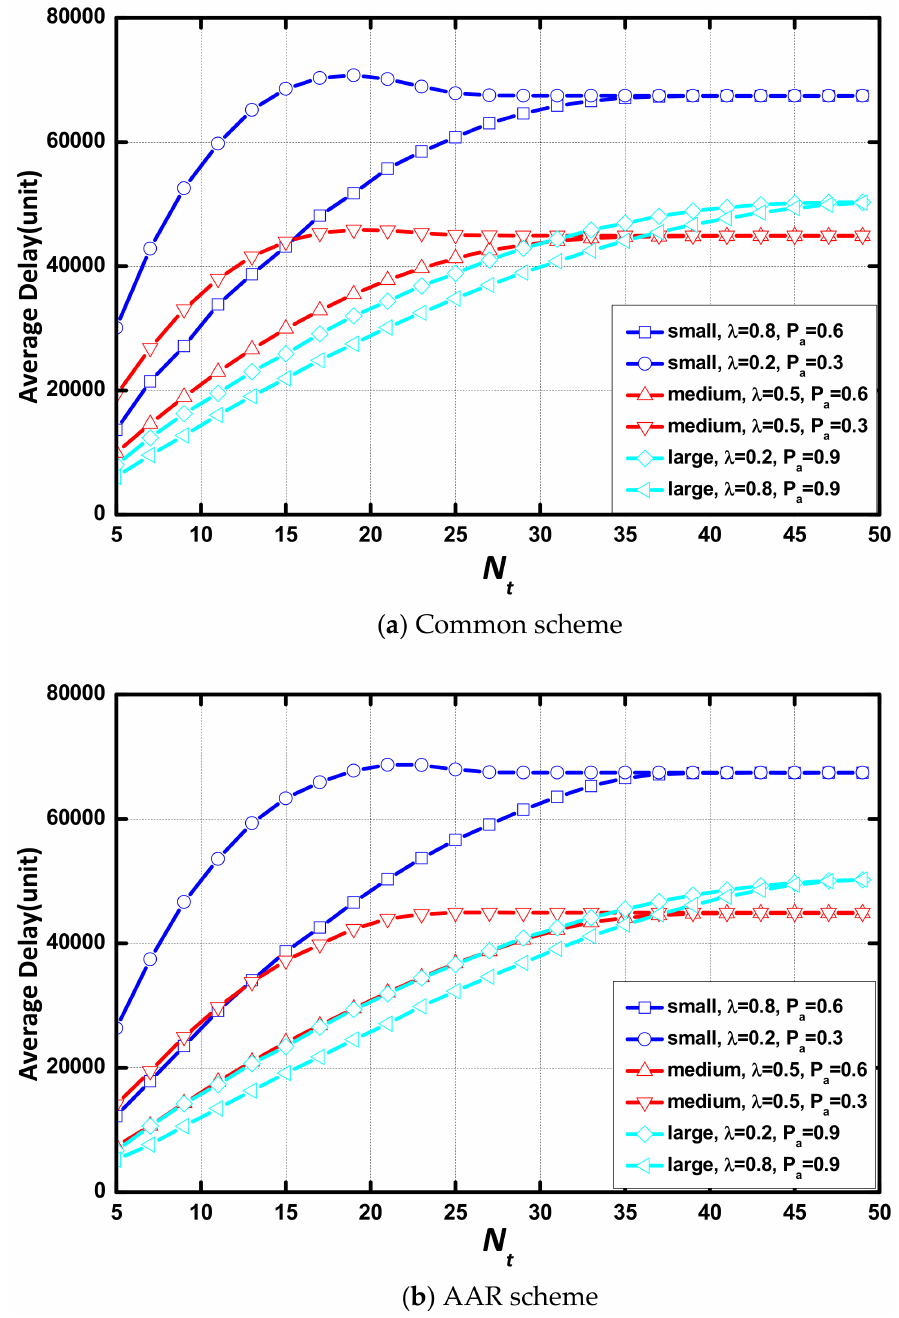
Figure 9. Average delay vs. N t in different